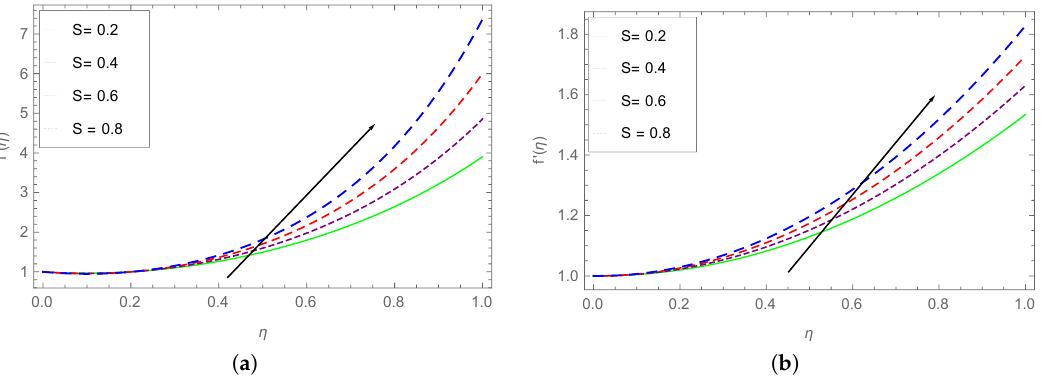
Figure 4. ( a ) Impact of S on f (cid:48) ( η ) , when β = 0.1, (cid:101) = 0.2 and ( b ) Impact of β on f (cid:48) ( η ) , when β = 0.01, (cid:101) = 0.01.